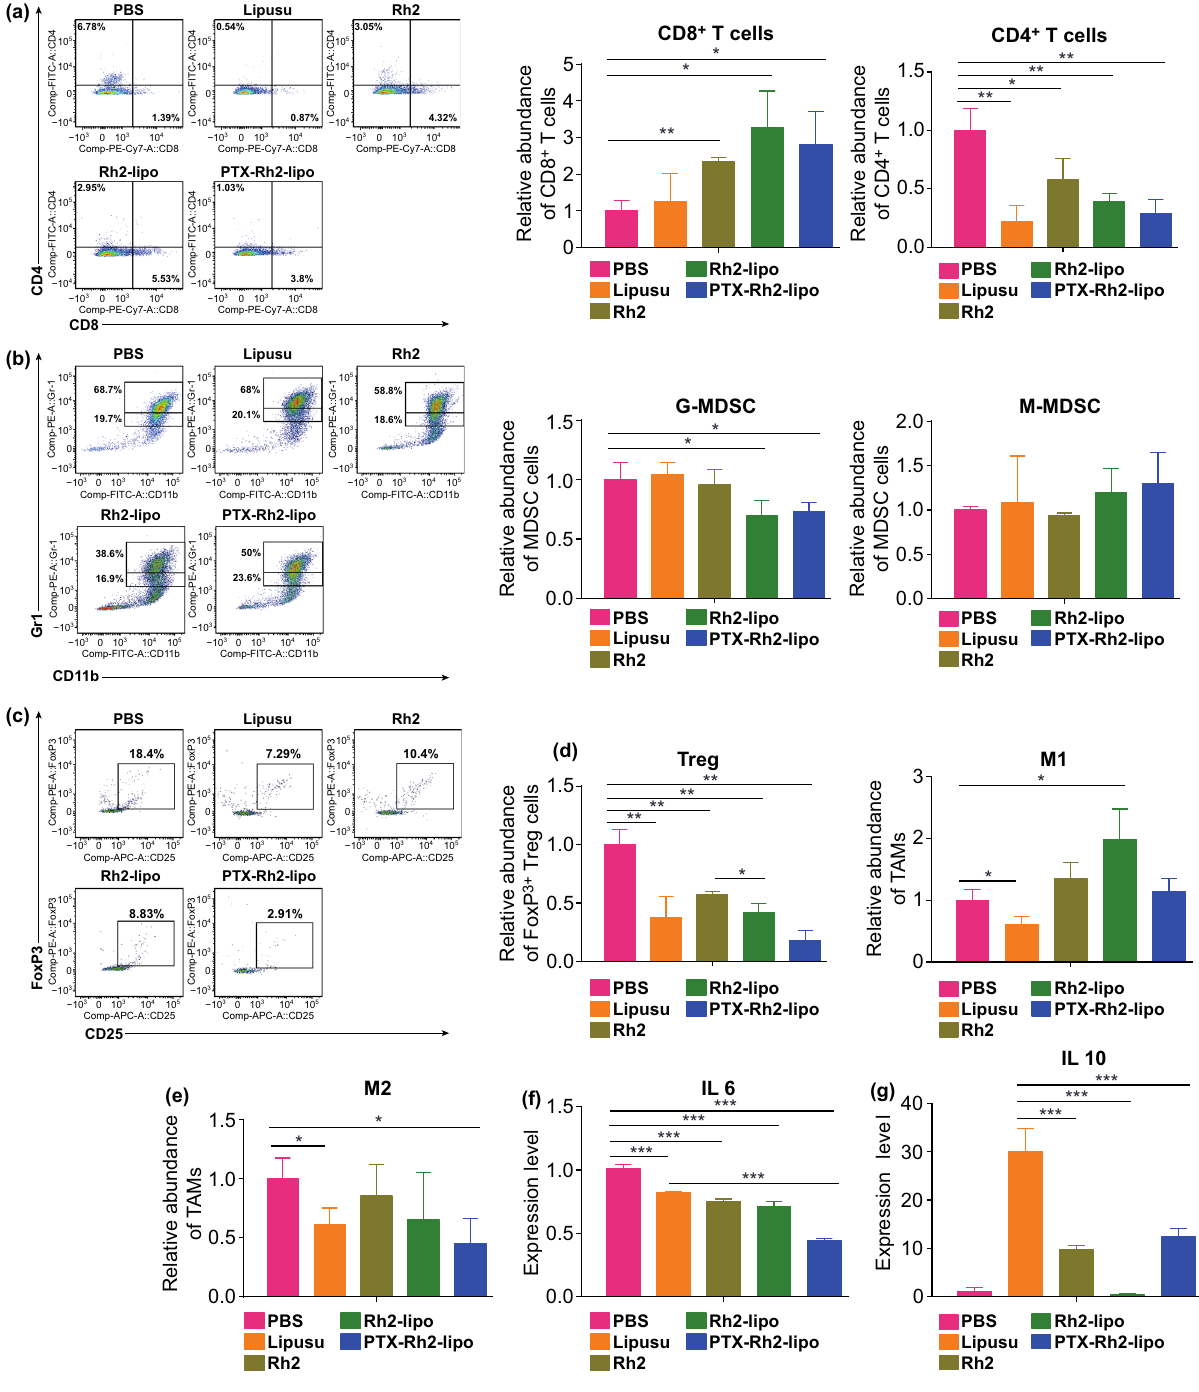
Fig. 7 Rh2 worked as a chemotherapy adjuvant, which reversed immunosuppressive TME. a Relative abundance of CD4 + , CD8 + cells in tumor tissues was detected by flow cytometry. b Flow cytometry gating and histograms analysis of CD11b + /Gr-1 + MDSC cells in tumors. Double positive cells contain two populations, including Gr-1 high CD11b + granulocytic (G-MDSC) and Gr-1 int CD11b + monocytic (M-MDSC) MDSC subsets. c Flow cytometry gating and histogram analysis of FoxP3 + T regulatory cells in tumors. d , e The percentages of TAM populations with specific macrophage markers M1-type (CD11b +/F4/80 +/CD86 +) and M2-type (CD11b +/F4/80 +/CD206 +) in tumor tissues were detected by flow cytometry. f , g Tumor cytokine IL6 and IL10 level were detected by using RT-PCR. * P < 0.05, ** P < 0.01 and *** P < 0.001, ( n = 3; mean ±